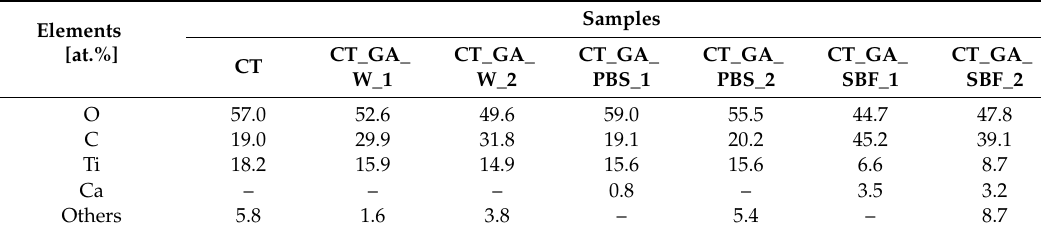
Table 3. Atomic percentages of the elements detected on the samples by XPS survey analyses. (Uncertainty of measurements 0.5 at.%–1